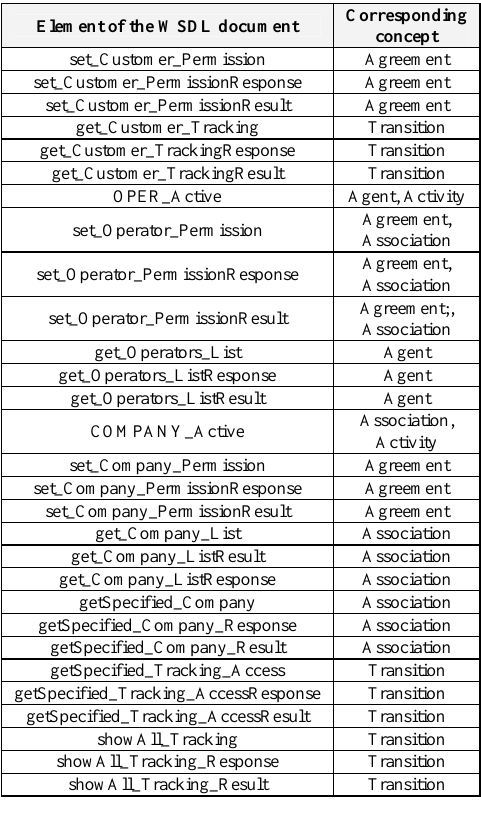
Table 4. The proposed manual associations Element of the WSDL